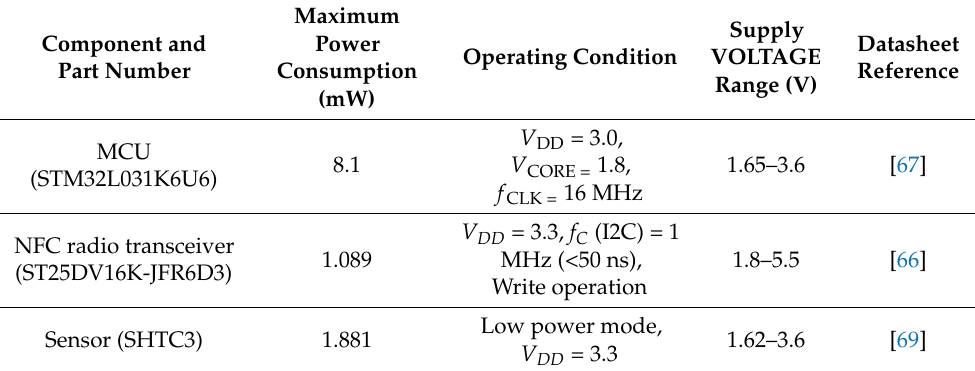
Table 2. Electrical specifications for IC components (datasheet) in developed NFC